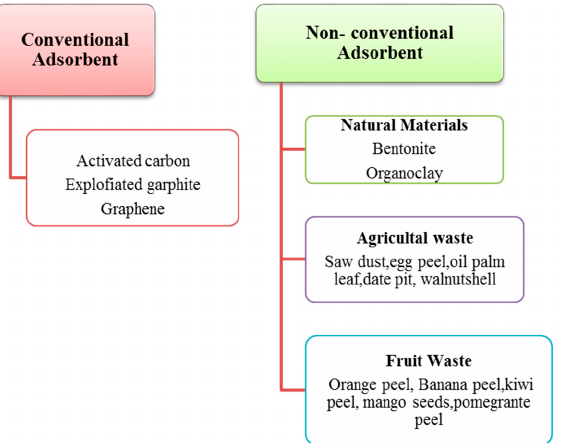
Figure 5. Different conventional and non-conventional adsorbents for PW treatment.